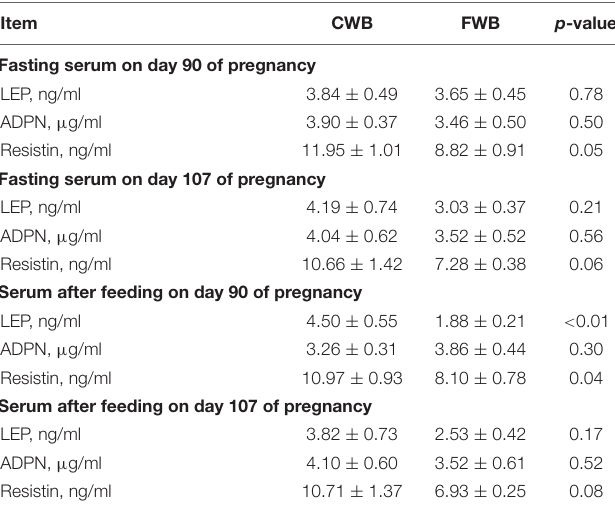
TABLE 4 | Effects of different particle sizes of wheat bran on maternal serum adipocytokines during gestation. Item CWB FWB p